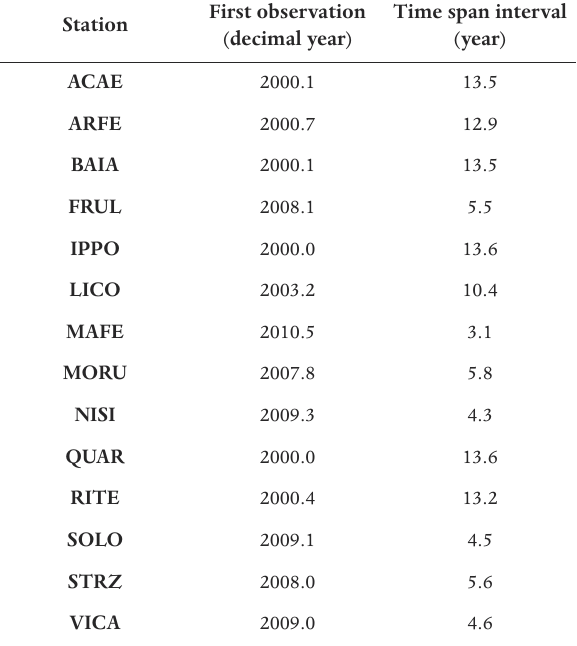
Table 1. First observation and time span interval of the GPS sta- tions used in this